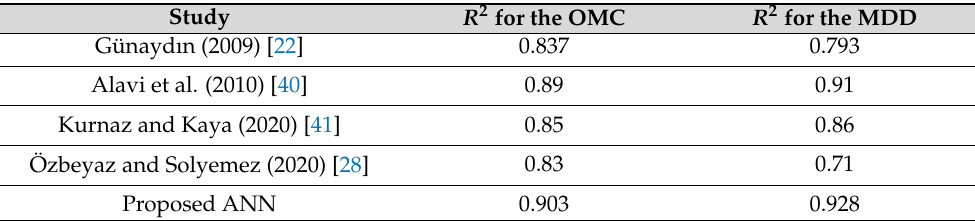
Table 6. The performance of the ANNs proposed in the literature and the proposed ANN in this study.